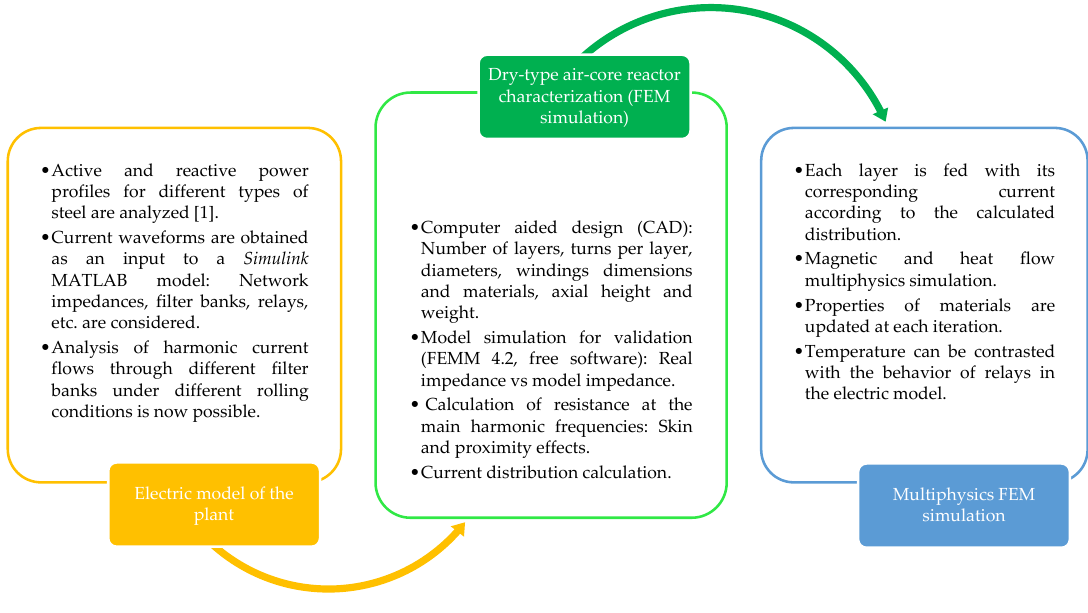
Figure 3. Simplified flowchart of the proposed study.